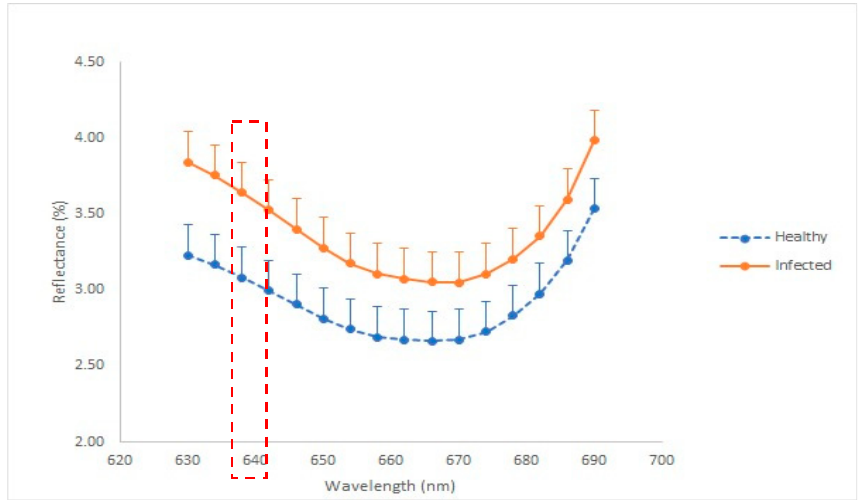
Figure 4. Graph of reflectance (%) against wavelength (nm) for healthy and infected seedlings.